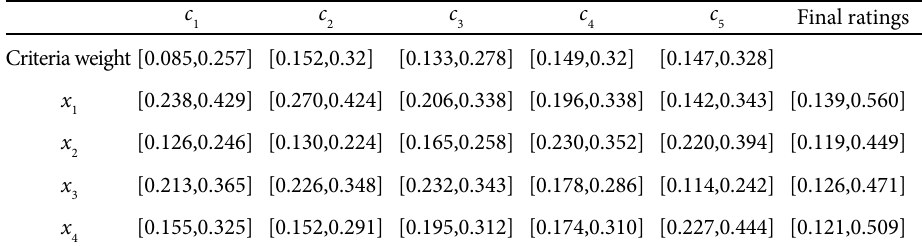
Table 3. Final overall ratings